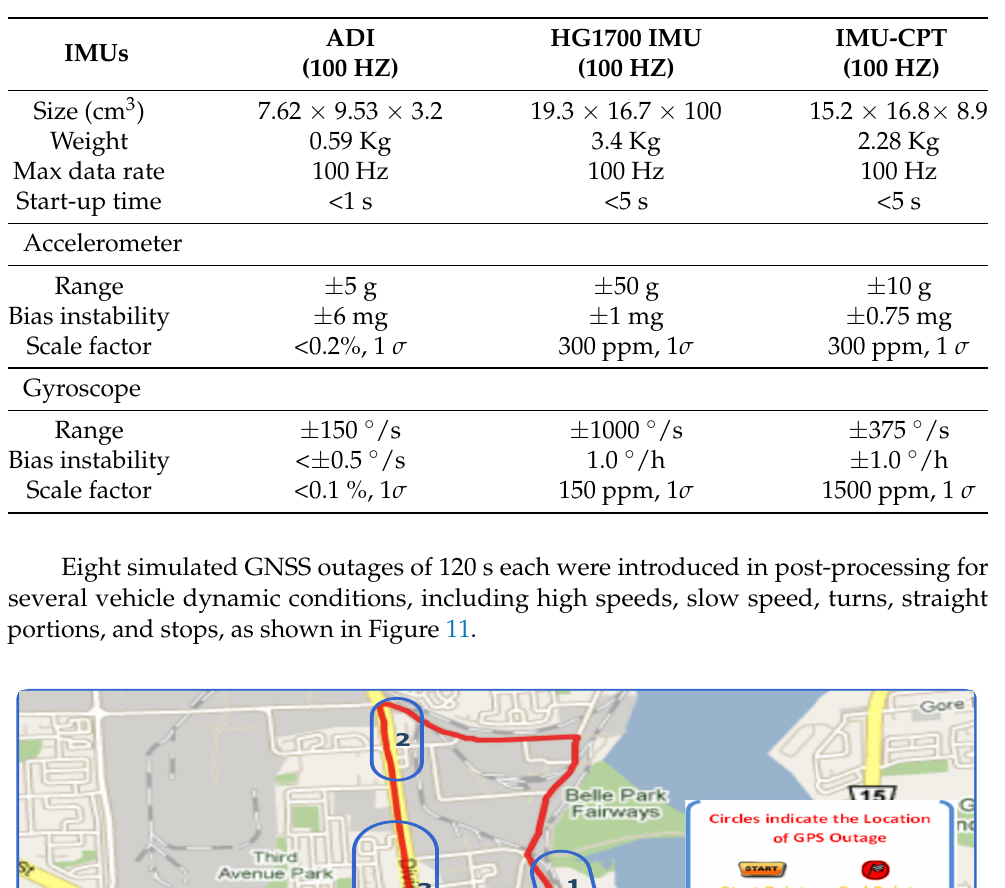
Table 1. Performance characteristics of imus.